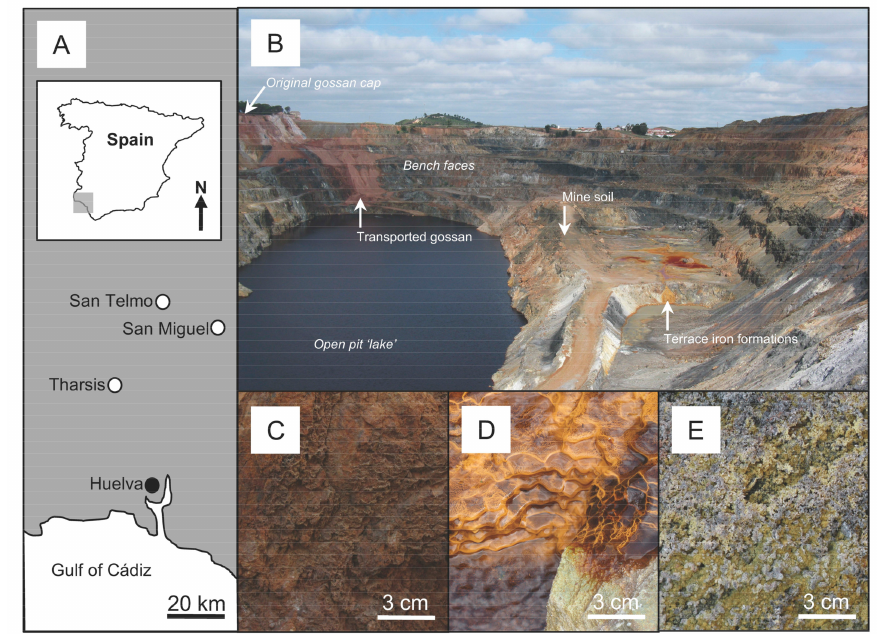
Figure 1. A map of southern Spain and locations of the abandoned San Telmo, San Miguel and Tharsis open pit mines ( A ); a schematic photograph of an open pit mine illustrating the occurrences of regolith materials and regions from which representative samples were obtained ( B ); representative photographs of transported gossan ( C ); terrace iron formation ( D ); and mine soils ( E